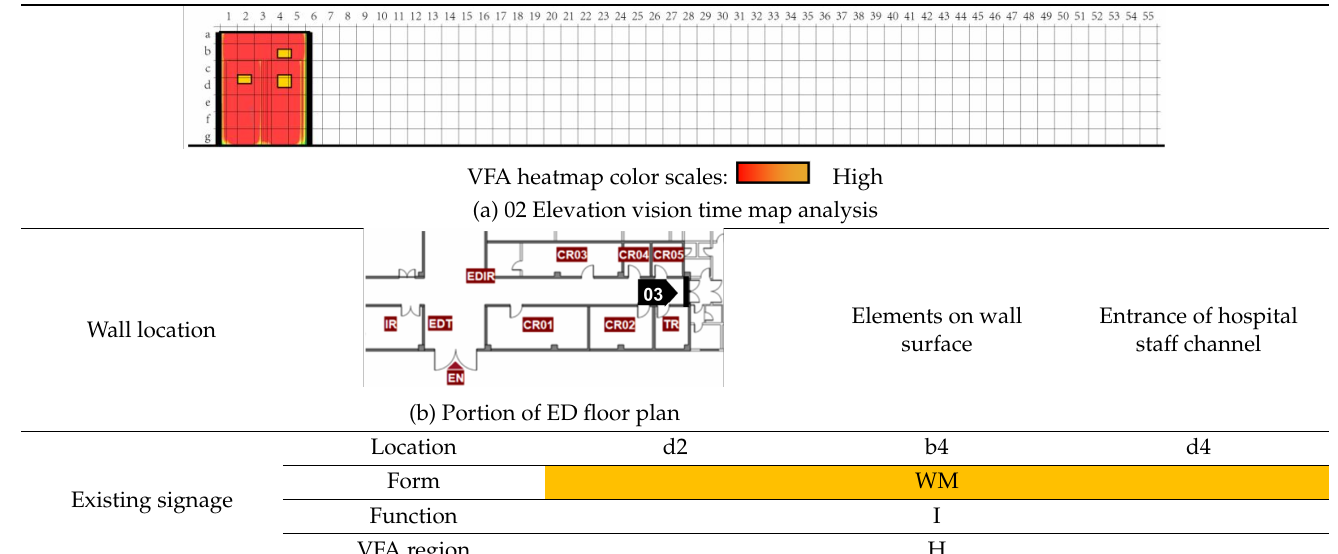
Table 7. 03 Elevation comparative